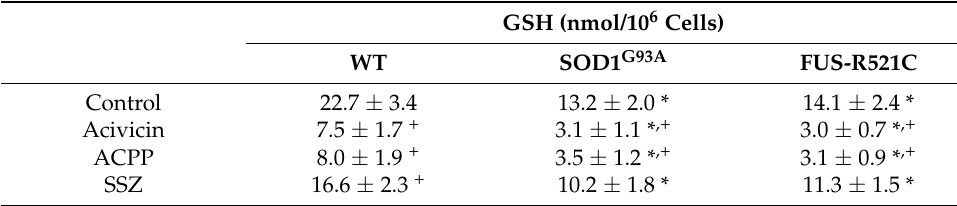
Table 7. Effect of inhibition of GGT activity or Cys/cystine uptake on GSH levels in astrocytes. As- trocytes isolated from wild-type and ALS mice at an advanced state of progression were incubated in the absence or presence of acivicin (0.05 mM), ACPP [(1)-amino(1-(3,5-dichlorophenyl)-3,5-dimethyl- 1H-pyrazol-4-yl)acetic acid, 0.1 mM] or SSZ (sulfasalazine, 0.2 mM) during a 24 h-time period before measuring GSH levels. The culture medium contained extracellular GSH and cyst(e)ine at a concen- tration of 10 a 1 mM, respectively. Data are mean values ± SD for n = 5–6. * p < 0.01 comparing values obtained in ALS models versus wild-type controls. + p < 0.01 comparing the different inhibitors versus controls.